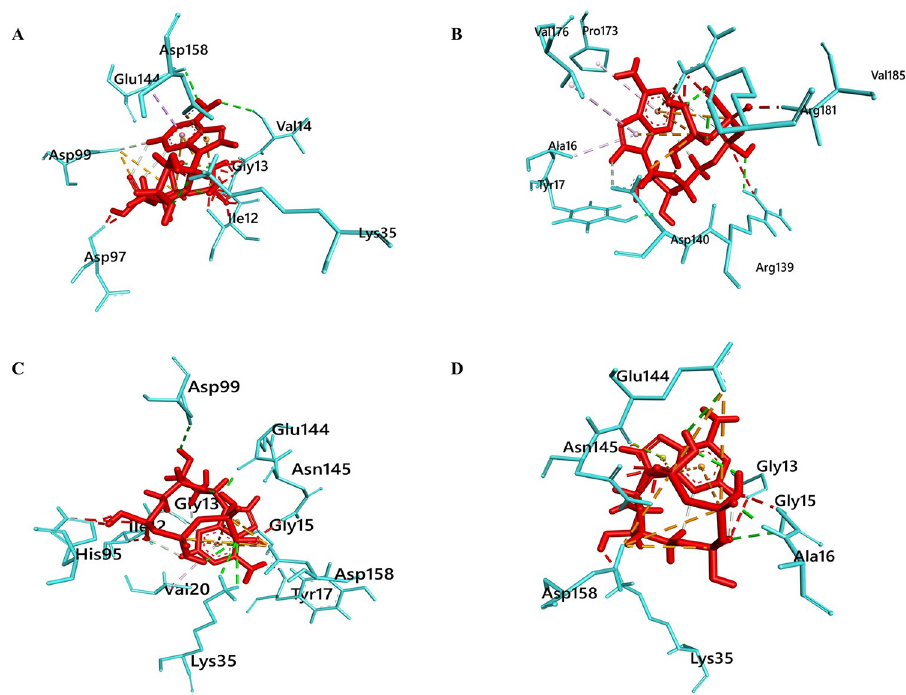
Fig 6. Protein-ligand residual interaction analysis of (A) Native CDK4 (Aqua) with ATP (red) (B) G15S mutant (aqua) with ATP (red) (C) D140Y mutant (aqua) with ATP (red) and (D) D140H mutant (aqua) with ATP (red). The interacting bonds are displayed as: Conventional hydrogen bonds/ Carbon hydrogen bonds as green line, pi-pi stack/pi-alkyl as pink lines, Salt bridge/ attractive charge/ electrostatic as brown lines.